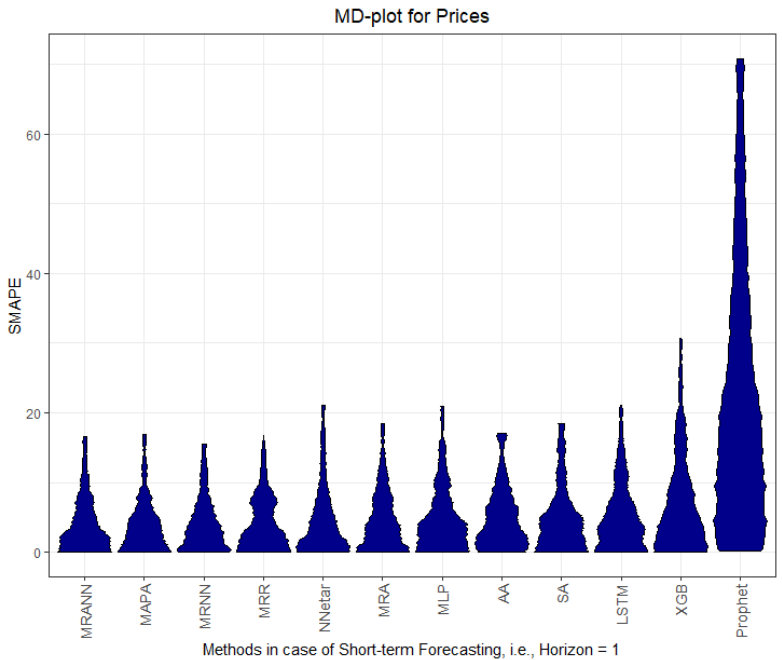
Figure A4. Mirrored density plot of Symmetric Mean Absolute Percentage Errors (SMAPE) computed with a rolling forecasting origin for horizon 1 on dataset Prices.